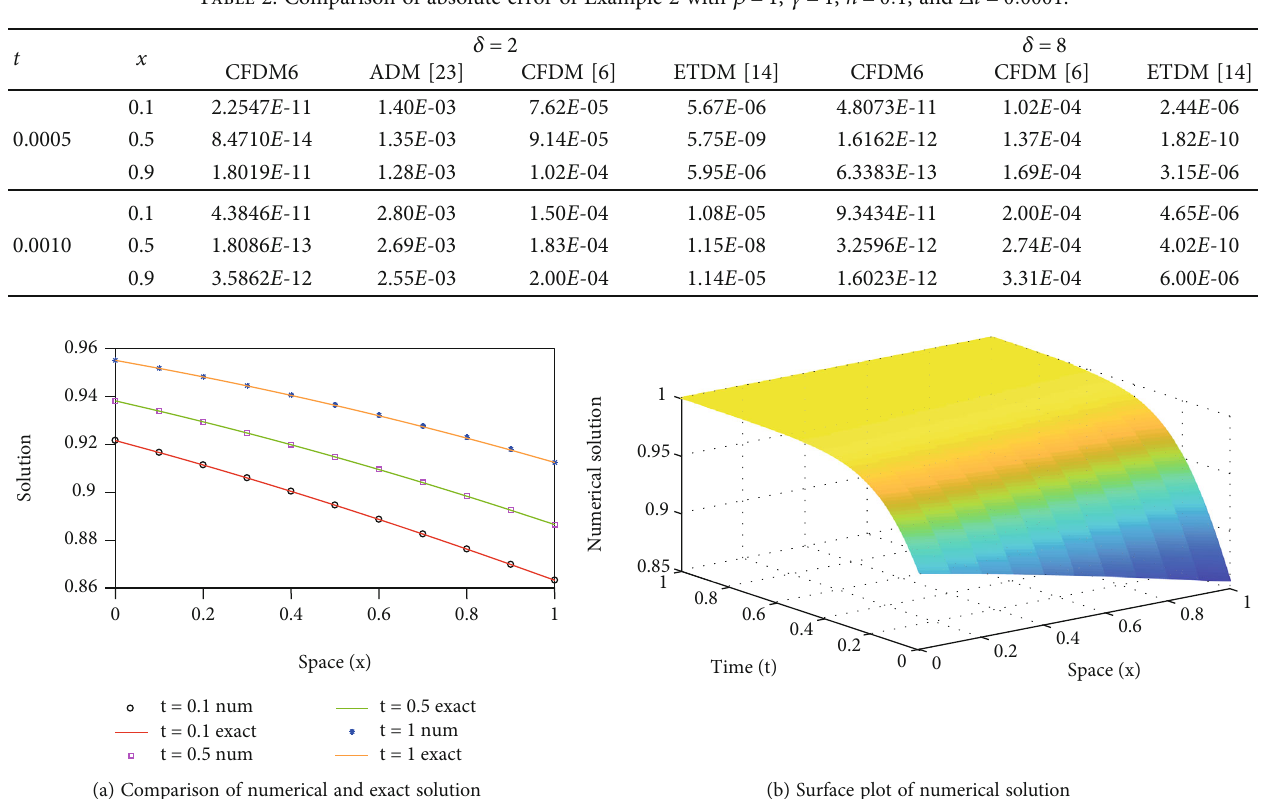
Table 2: Comparison of absolute error of Example 2 with β = 1 , γ = 1 , h = 0 : 1 , and Δ t = 0 : 0001 .